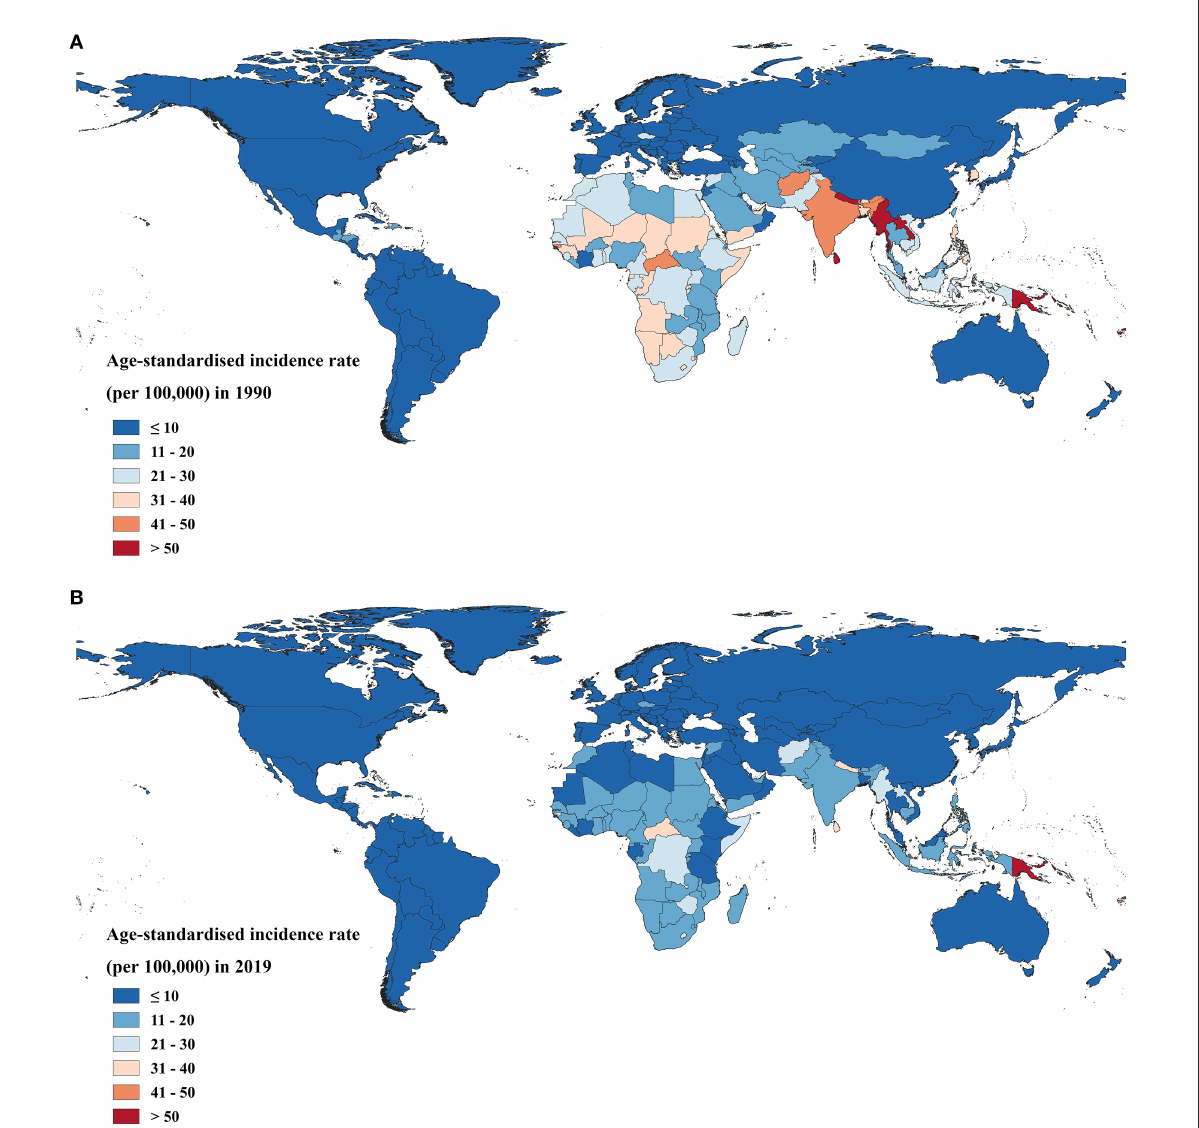
FIGURE4 The age-standardised mortality rate in 1990 (A) and 2019 (B) for asthma in 204 countries and territories worldwide.